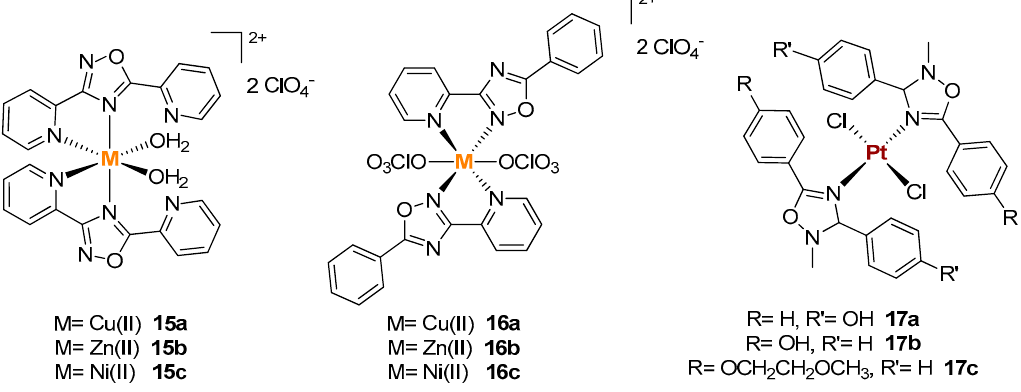
Figure 8. Structures of Ni(II), Cu(II), and Zn(II) complexes with ligands 3,5-bis(2 ′ -pyridyl)-1,2,4-oxadiazole and 3-(2 ′ -pyridyl)5-(phenyl)-1,2,4-oxadiazole, respectively.